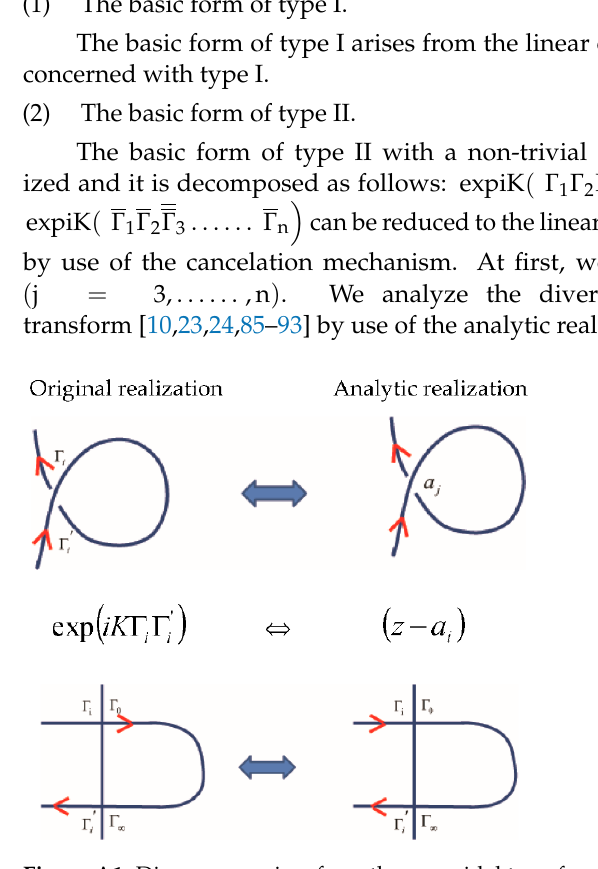
Figure A1. Divergence arises from the monoidal transform by use of the analytic realization.